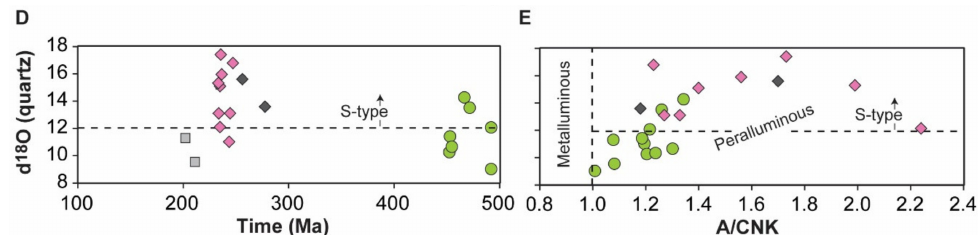
Figure 6. Summary isotopic compositions of igneous rocks that crystallised during 499–112 Ma in Venezuela, Colombia and Ecuador. ( A ) whole rock Nd, ( B ) uncorrected whole rock and feldspar (Triassic only) Pb isotopic compositions showing fields (uncorrected data) for major basement regions in Colombia [75] and western Gondwana and Laurentia [76]. The black line shows the terrestrial evolution trend [72]. ( C ) Hf isotopic compositions of magmatic rims of zircons showing the corre- sponding two-stage Lu-Hf model ages (calculated using a 176 Lu/ 177 Hf ratios of 0.0113 and 0.0384 for average and juvenile continental crust, respectively; [77]) and highlighting periods of compression and extension. ( D , E ) Comparisons of d 18 O (quartz) with time (zircon 238 U- 206 Pb concordia age) and Aluminium Saturation Index (A/CNK) highlighting the S-type field of Harris et al. (1997) [74]. Data are from Ordoñez-Carmona et al. (2006) [78], Mantilla-Figueroa et al. (2012) [4], Cochrane et al. (2014a, b) [21,46], Bustamante et al. (2016, 2017) [22,41], Van der Lelij et al. (2016, 2019) [2,71], Paul et al. (2018) [23], Spikings et al. (2015, 2021) [1,36], Tazzo-Rangel et al. (2019; orthogneisses only) [3]. Symbols are the same as in Figure